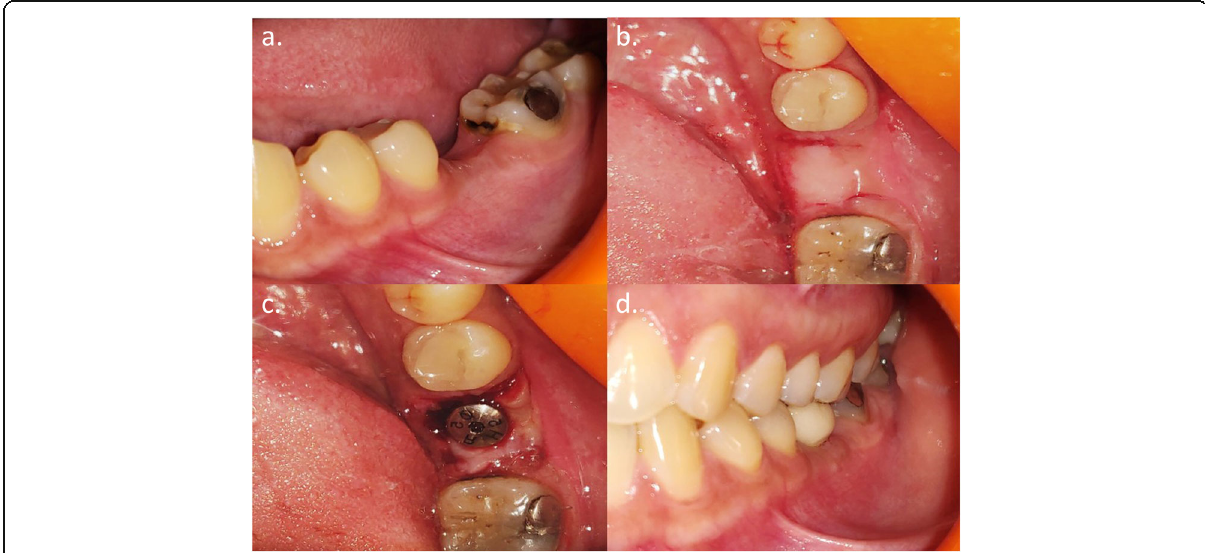
Fig. 2 Peri-implant keratinized mucosa augmentation for group A. a Pre-operative. b Incisions placed. c Flap displaced buccally and stabilized by a healing abutment. d 1 year